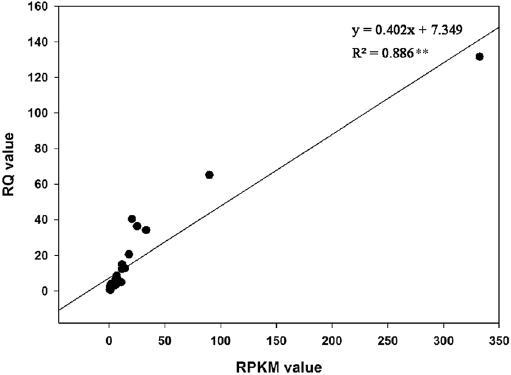
Figure 4. Correlation between qRT-PCR and data obtained from transcriptome analysis. The real-time PCR log